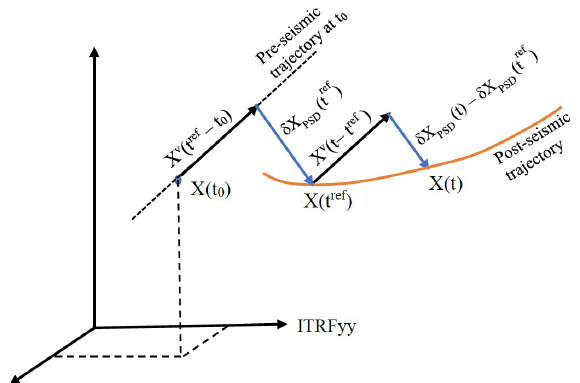
Fig. 2. Time-dependent coordinates: t 0 and t tref are the pre-seismic and post-seismic reference epochs, respectively.